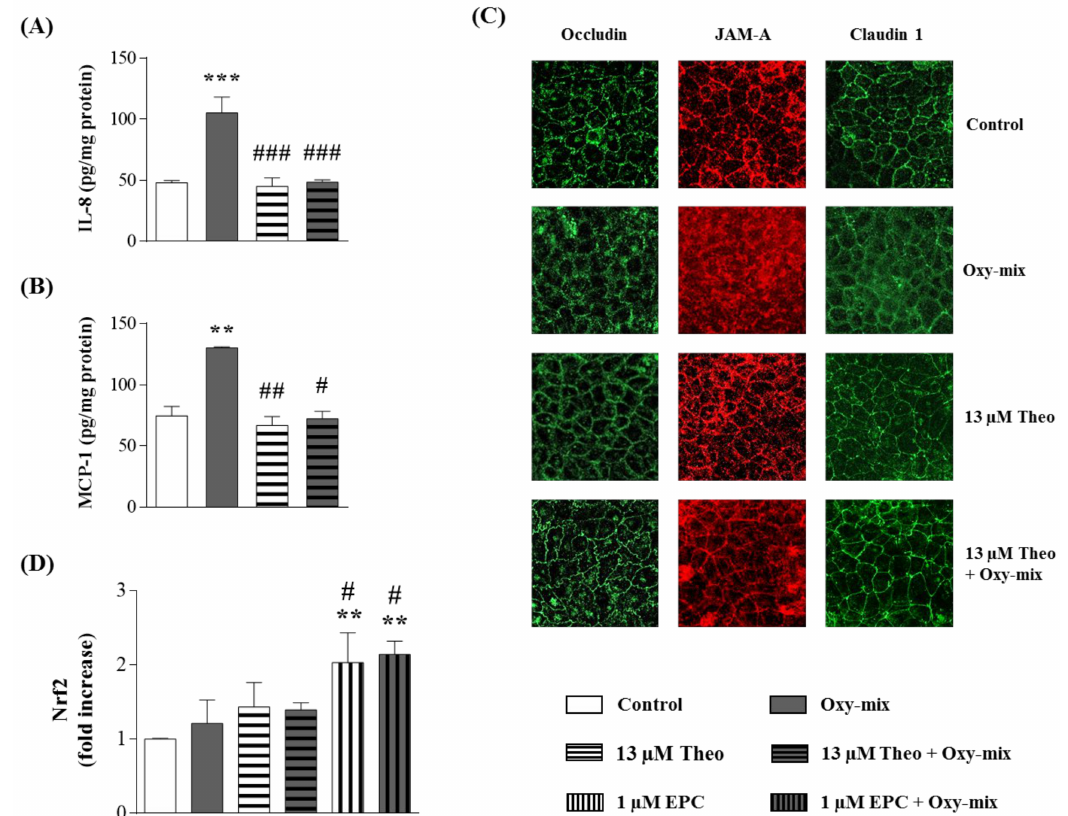
Figure 5. Theobromine prevented IL-8, MCP-1 and TJ changes but did not increase Nrf2 gene expression in differentiated CaCo-2 cells treated with Oxy-mix. Differentiated CaCo-2 cells were pretreated or not with 13 µ M theobromine for 1 h and incubated with 60 µ M Oxy-mix for 24 h. Cell release of IL-8 ( A ) and MCP-1 ( B ) in the incubation medium was detected by ELISA and evaluated. Values are shown as pg chemokines normalized for cell incubation medium mg proteins (pg/mg protein). Data are means of three independent experiments ( n = 3) evaluated in triplicate ± SD. Claudin 1, occludin, and JAM-A cellular distribution ( C ) was evaluated in differentiated CaCo-2 cell lysates in presence of 13 µ M theobromine (1 h cell pretreatment) incubated or not with 60 µ M Oxy-mix for 24 h. Fluorescence microscopy was used to visualize TJ cellular distribution ( × 400 magnification). Claudin 1 and occludin proteins were visualized as green fluorescence, JAM-A was visualized as red fluorescence (see Materials and Methods). Nrf2 gene expression ( D ) was evaluated through qRT-PCR in differentiated CaCo-2 cells after 6 h Oxy-mix incubation in presence or absence of 13 µ M theobromine. The histograms represent means of three independent experiments ( n = 3) evaluated in triplicate ± SD, normalized to the corresponding housekeeping gene actin and expressed as fold induction vs. control. Theo: theobromine; EPC: ( − )-epicatechin.